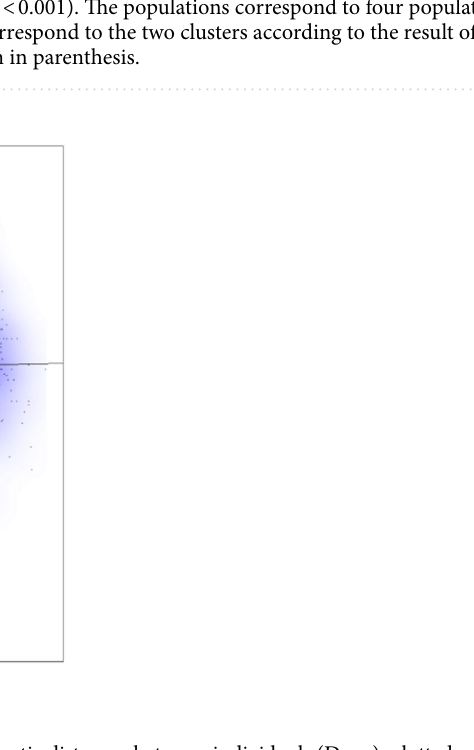
Figure 4. Isolation by distance. Pairwise Edwards genetic distances between individuals (Dgen), plotted against the Euclidean geographical distances (Dgeo; km) for the same individuals. Local density of points plotted using a two-dimensional Kernel